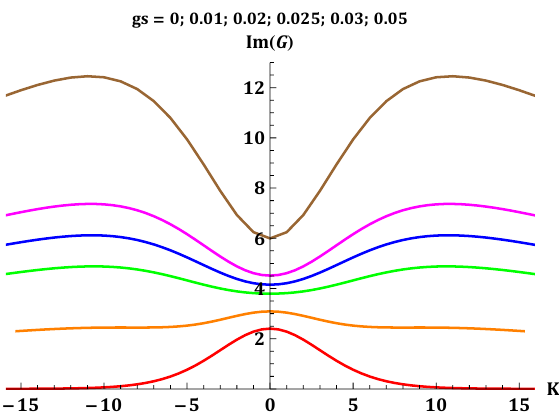
Figure 7. Plot of spectral function A vs. k x with k y = 0 for worldvolume fermions. From bottom to top: g s = 0 (red), 0.01 (orange), 0.02 (green), .025 (blue), .03 (magenta), .05